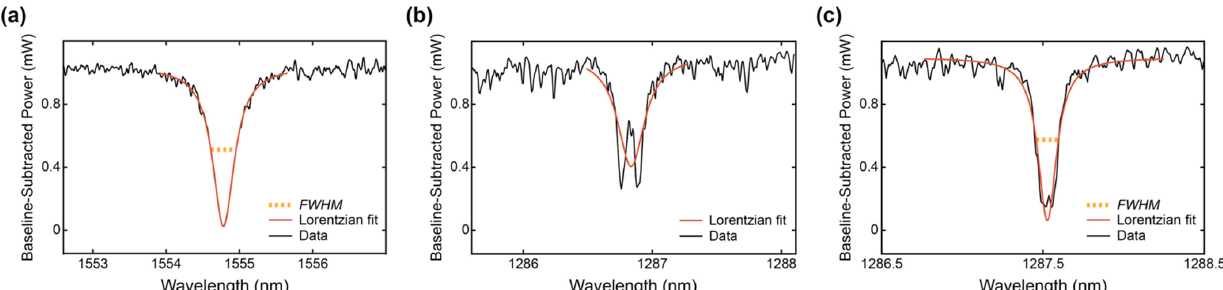
Figure 9. ( a ) Example of a non-split resonance peak from a spectrum measured for resonator C6, showing the Lorentzian fit and full width at half maximum ( FWHM ) calculated by the analysis script. ( b ) Example of a split resonance peak with a low R 2 (0.794) from a spectrum measured for resonator O3, showing the Lorentzian fit calculated by the analysis script ( FWHM not calculated, as this peak exhibited a R 2 value below the cutoff of 0.85). ( c ) Example of an apparent split resonance peak with a high R 2 (0.951) from a spectrum measured for resonator O3, showing the Lorentzian fit and FWHM calculated by the analysis script.